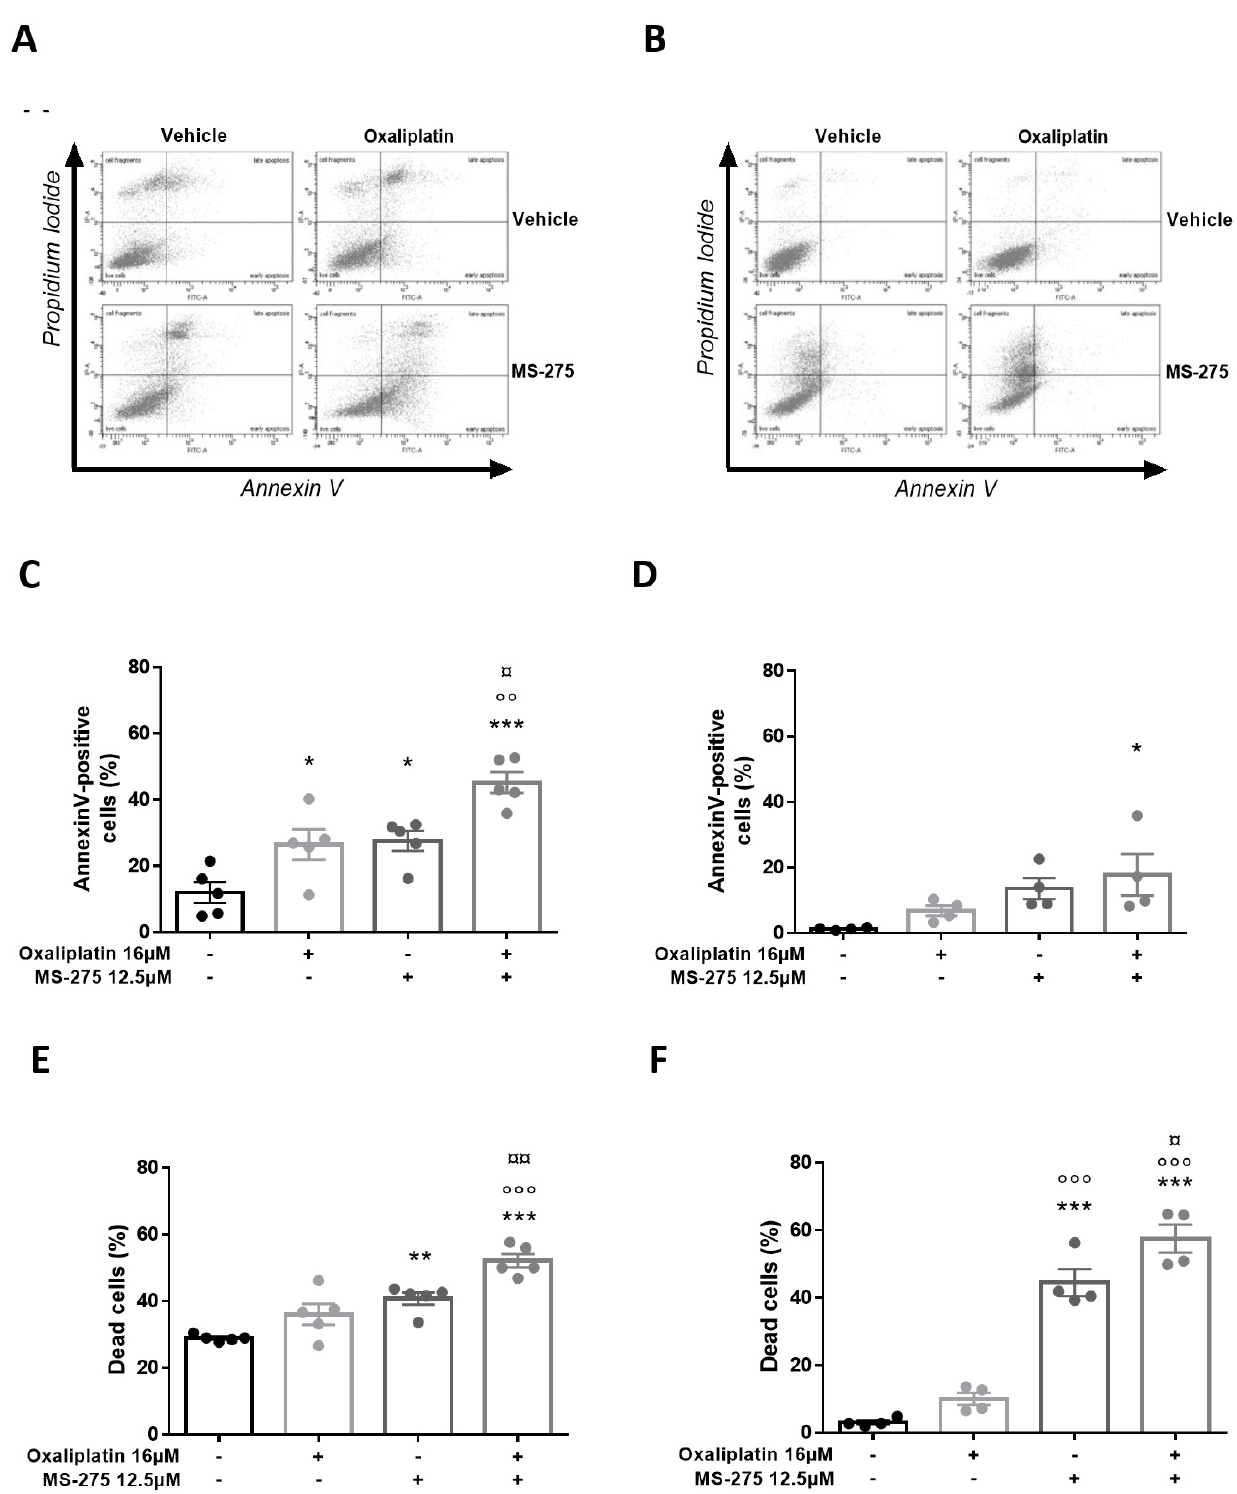
Figure 6. Oxaliplatin and MS-275 effects on apoptosis and cell death in T84 and HT29 cells. Annexin V and Propidium Iodide (PI) staining was performed on T84 ( A ) and HT29 ( D ) cell lines followed by flow cytometry analysis. Effects of oxaliplatin (16 µM) with or without MS-275 (2.5 µM) on T84 apoptosis ( B ) and cell death ( C ) and on HT29 apoptosis ( E ) and cell death ( F ). The average results from at least three independent experiments are presented. Values are expressed as mean ± SEM. Statistical analysis was performed using two-way ANOVA, detailed in Supplementary Table S1, with Tukey’s multi-comparisons post-hoc test; * for p < 0.05; ** for 0.01; *** p < 0.001, versus the vehicle group; °° for p < 0.01, °°° for p < 0.001, versus the oxaliplatin group; ¤ for p < 0.05, ¤¤ for p < 0.01, versus the MS-275 group.